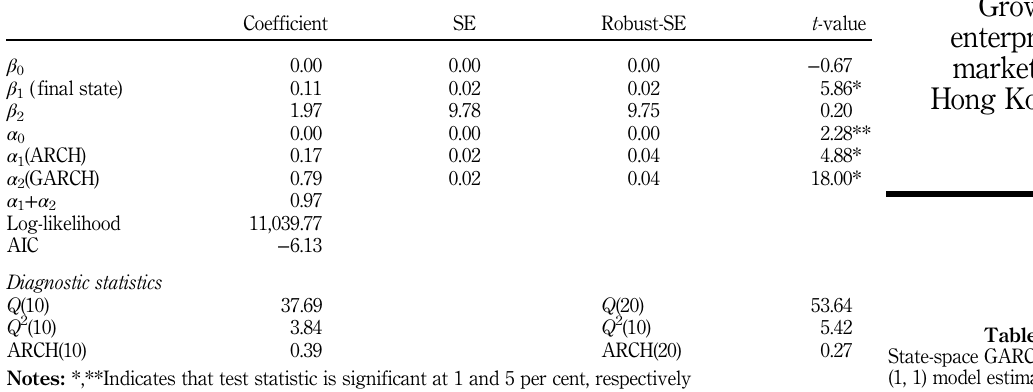
Figure 3 portrays the evolution of market efficiency in GEM by showing the time path of AR ) (red line) together with 95 per cent confidence interval (black lines), (1) coefficient ( β 1 t obtained from Kalman filter estimation. When the time path approaches zero, a tendency towards efficiency is implied and vice versa. As SMEs are growing rapidly and market participants and regulatory environment becomes more sophisticated over time, the GEM has been developing robustly in terms of market size (market capitalisation) and liquidity provision (trading turnover) since launch, see Figures 1 – 2. Increasing market capitalisation implies positive sentiments about the future prospects of the listed companies since market